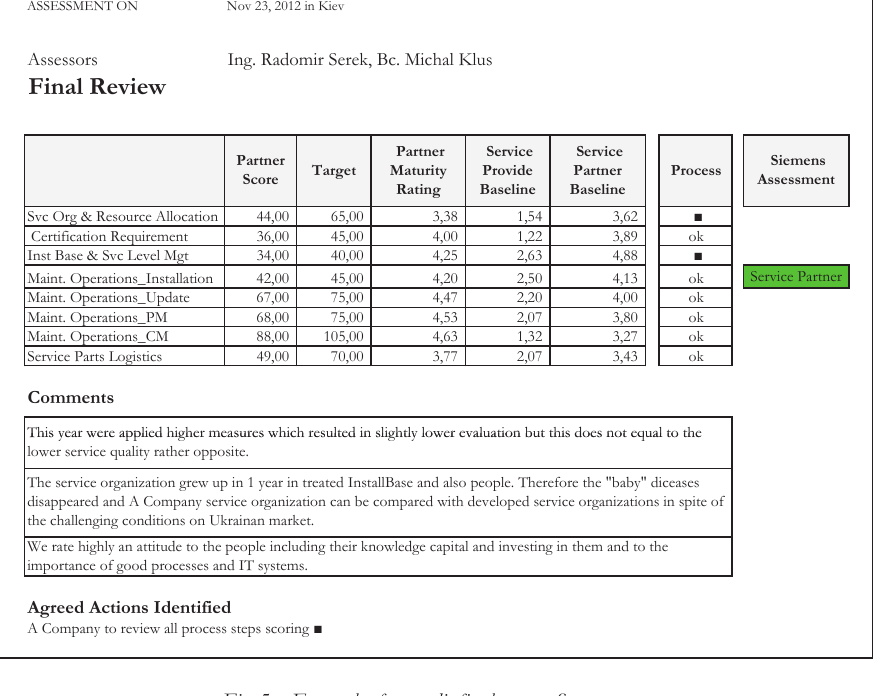
Fig. 5 – Example of an audit final report. Source: